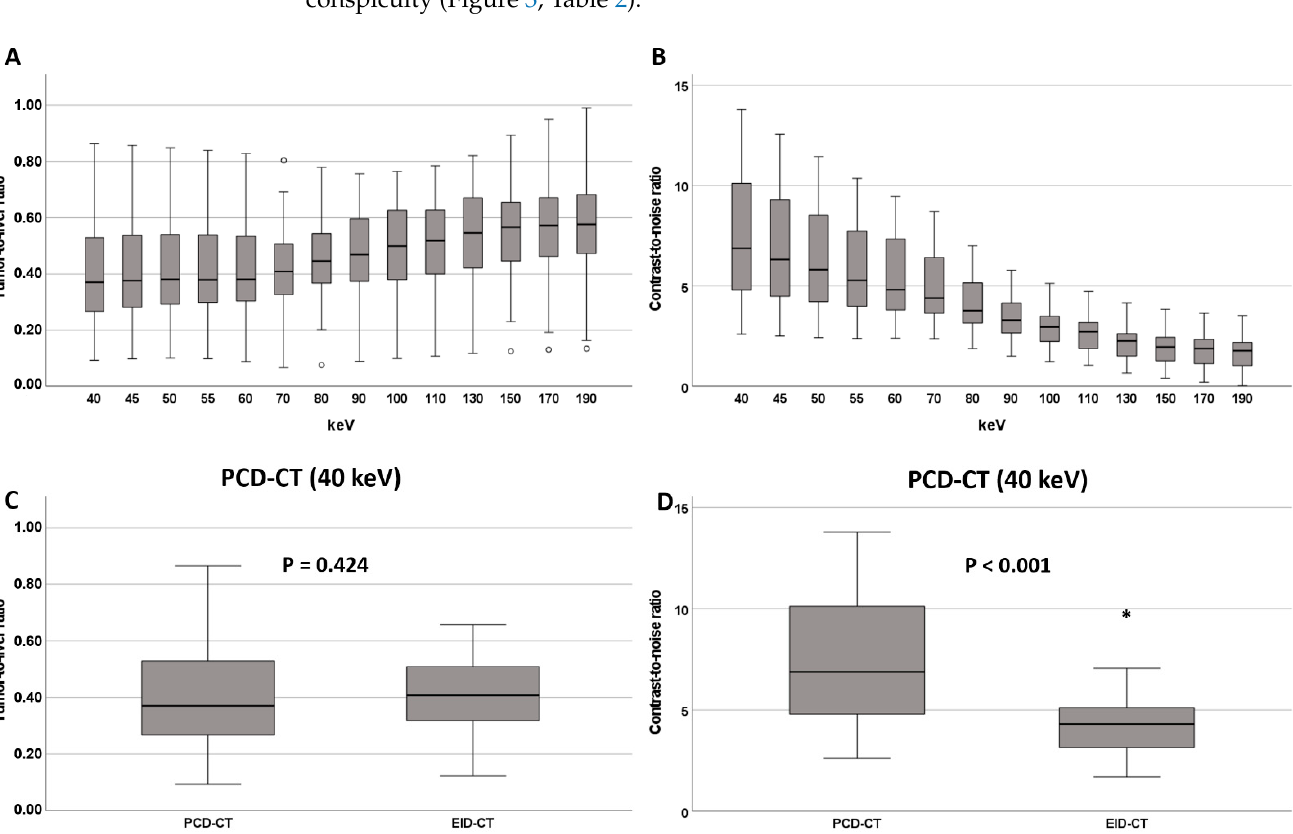
Figure 3. ( A ) Tumor-to-liver ratio and ( B ) contrast-to-noise ratio at different keV levels on the PCD-CT. Comparison of tumor-to-liver ratio and CNR between EID-CT and PCD-CT at 40 keV ( C , D ). * and ◦ denote outliers.